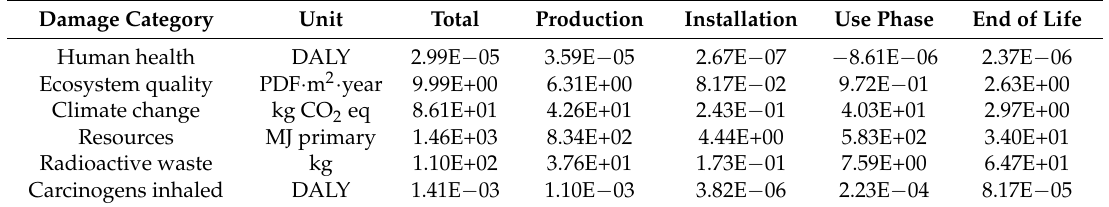
Table 3. LCIA results at end-point level of 1 m 2 of nanoTiO 2 self-cleaning coated float